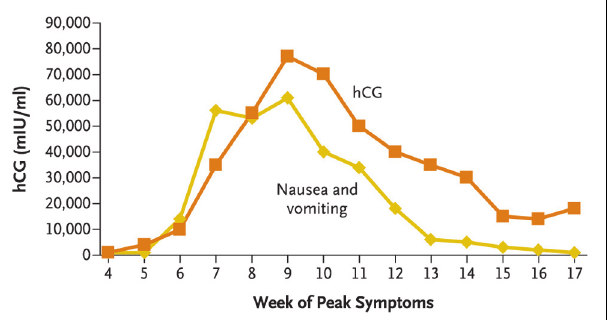
FIGURE 4 | Human chorionic gonadotropin (hCG) levels (and reports of nausea and vomiting) as a function of number of weeks of pregnancy. hCG level peaks during the first trimester. From Niebyl (2010), permission